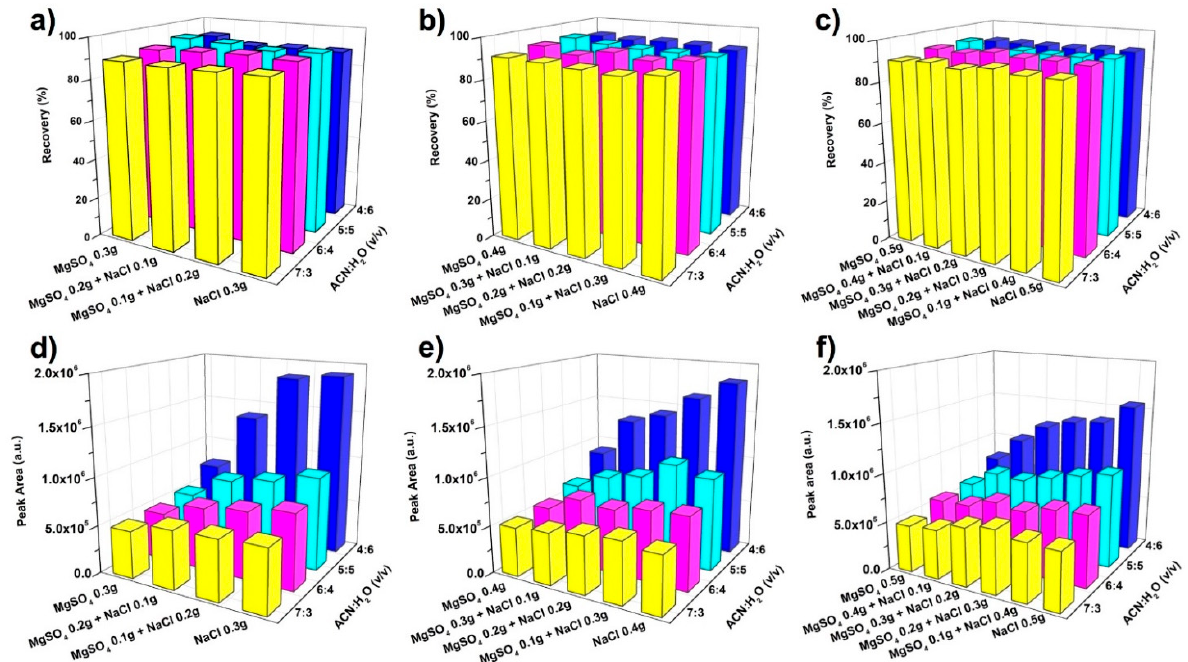
Figure 2. Effects of salts and ACN-H 2 O mixture on the calculated recovery ( a , b , and c ) and signal response ( d , e , and f ) of bisphenol A (BPA). The total mass of salts were 0.3 g ( a and d ), 0.4 g ( b and e ), and 0.5 g ( c and f ). Mean values of triplicate experiments are presented.